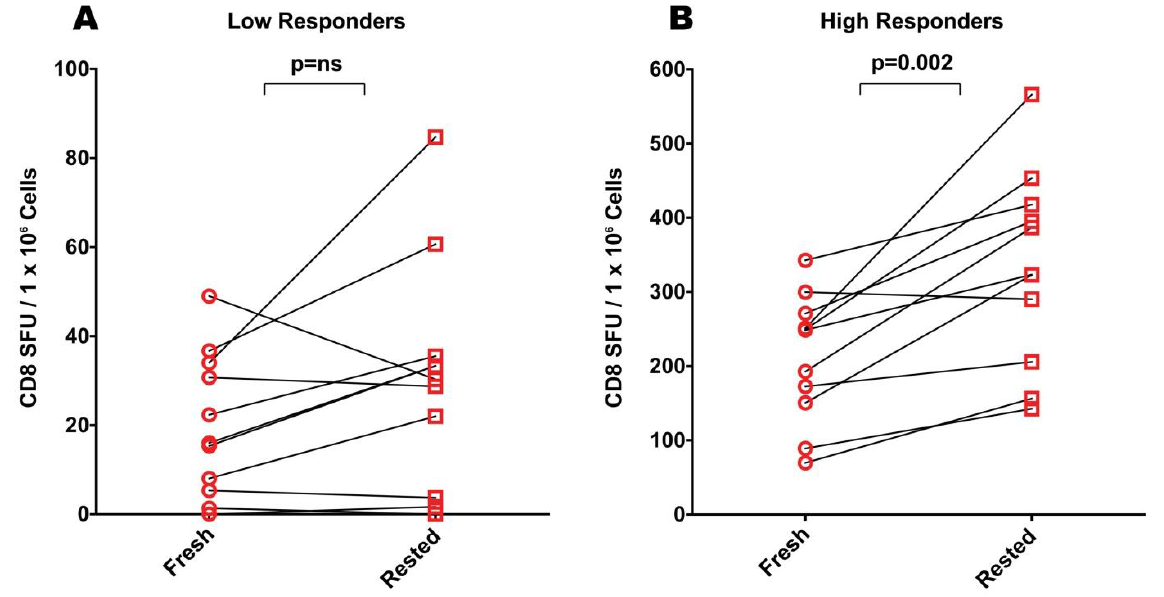
Figure 2. (cid:38)(cid:82)(cid:80)(cid:83)(cid:68)(cid:85)(cid:76)(cid:86)(cid:82)(cid:81)(cid:3) (cid:82)(cid:73)(cid:3) (cid:38)(cid:40)(cid:41)(cid:3) (cid:85)(cid:72)(cid:86)(cid:83)(cid:82)(cid:81)(cid:86)(cid:72)(cid:86)(cid:3) (cid:72)(cid:79)(cid:76)(cid:70)(cid:76)(cid:87)(cid:72)(cid:71)(cid:3) (cid:69)(cid:92)(cid:3) (cid:73)(cid:85)(cid:72)(cid:86)(cid:75)(cid:79)(cid:92)(cid:3) (cid:87)(cid:75)(cid:68)(cid:90)(cid:72)(cid:71)(cid:3) (cid:11)(cid:179)(cid:73)(cid:85)(cid:72)(cid:86)(cid:75)(cid:180)(cid:12)(cid:3) (cid:68)(cid:81)(cid:71)(cid:3) (cid:85)(cid:72)(cid:86)(cid:87)(cid:72)(cid:71)(cid:3) cryopreserved PBMC in ELISPOT assays. ( A ) CEF- (cid:86)(cid:83)(cid:72)(cid:70)(cid:76)(cid:73)(cid:76)(cid:70)(cid:3) (cid:85)(cid:72)(cid:86)(cid:83)(cid:82)(cid:81)(cid:86)(cid:72)(cid:86)(cid:3) (cid:68)(cid:80)(cid:82)(cid:81)(cid:74)(cid:3) (cid:179)(cid:79)(cid:82)(cid:90)(cid:3) (cid:85)(cid:72)(cid:86)(cid:83)(cid:82)(cid:81)(cid:71)(cid:72)(cid:85)(cid:86)(cid:180)(cid:3)(cid:90)(cid:75)(cid:82)(cid:3)(cid:90)(cid:72)(cid:85)(cid:72)(cid:3)(cid:71)(cid:72)(cid:73)(cid:76)(cid:81)(cid:72)(cid:71)(cid:3)(cid:68)(cid:86)(cid:3)(cid:86)(cid:88)(cid:69)(cid:77)(cid:72)(cid:70)(cid:87)(cid:86)(cid:3)(cid:90)(cid:75)(cid:82)(cid:3)(cid:75)(cid:68)(cid:71)(cid:3)(cid:73)(cid:72)(cid:90)(cid:72)(cid:85)(cid:3)(cid:87)(cid:75)(cid:68)(cid:81)(cid:3)(cid:24)(cid:19)(cid:3)(cid:54) FU in freshly thawed PMBC. ( B ) CEF- (cid:86)(cid:83)(cid:72)(cid:70)(cid:76)(cid:73)(cid:76)(cid:70)(cid:3) (cid:85)(cid:72)(cid:86)(cid:83)(cid:82)(cid:81)(cid:86)(cid:72)(cid:86)(cid:3) (cid:68)(cid:80)(cid:82)(cid:81)(cid:74)(cid:3) (cid:179)(cid:75)(cid:76)(cid:74)(cid:75)(cid:3) (cid:85)(cid:72)(cid:86)(cid:83)(cid:82)(cid:81)(cid:71)(cid:72)(cid:85)(cid:86)(cid:180)(cid:3) (cid:90)(cid:75)(cid:82)(cid:3) (cid:90)(cid:72)(cid:85)(cid:72)(cid:3) (cid:71)(cid:72)(cid:73)(cid:76)(cid:81)(cid:72)(cid:71)(cid:3) (cid:68)(cid:86)(cid:3) subjects who had greater than 50 spots forming units (SFU) in freshly thawed PMBC. Data points obtained from the same donor before and after resting are connected by a line. Each data point represents the mean of triplicate antigen-stimulated wells. For each donor and antigen tested, the standard deviation was <20% of the mean value. For each sample, fresh or rested, the medium background was less than 10 spots per well. Non-parametric Wilcoxon signed-rank test was used to compare matched fresh vs . rested responses with a p -value (cid:148) 0.05 being considered